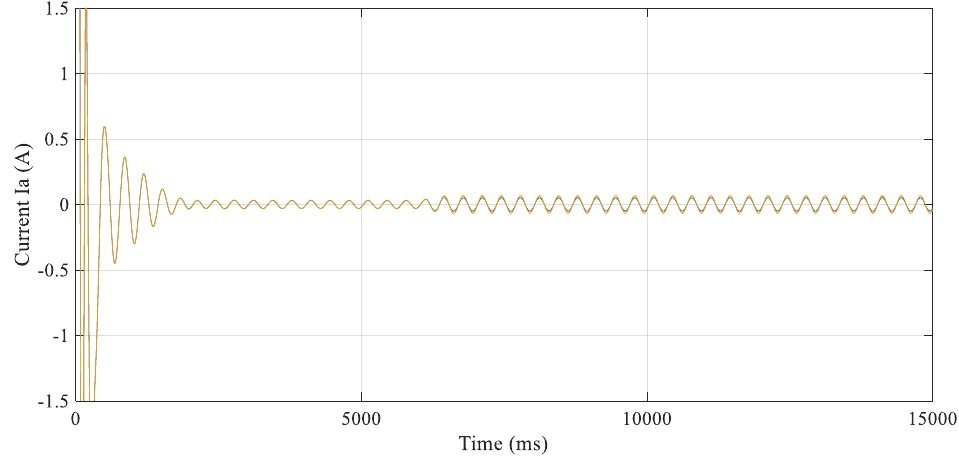
Figure 18. Reduction in current due to multiple faults in PV array under severe shading.